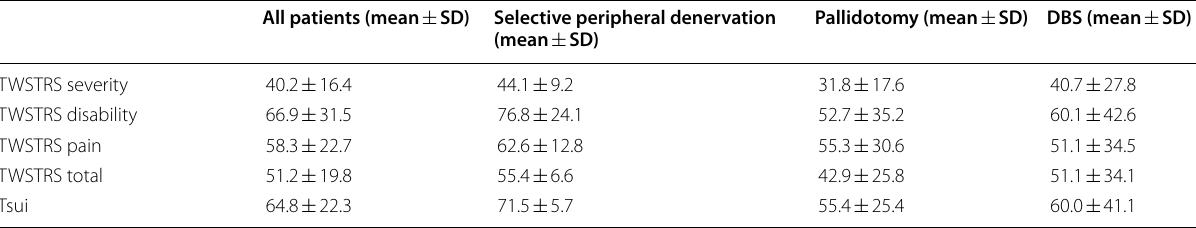
SD standard deviation